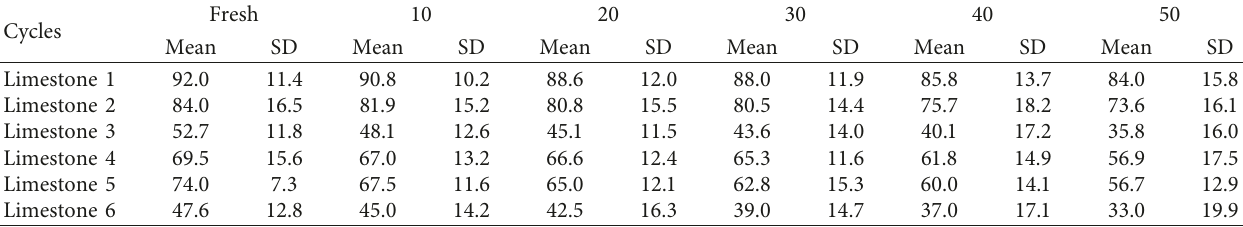
Table 2: Mean and standard deviation (SD) of unconfined compressive strength (UCS), MPa, values before and after frost cycles. Fresh 10 20 Cycles Mean SD Mean